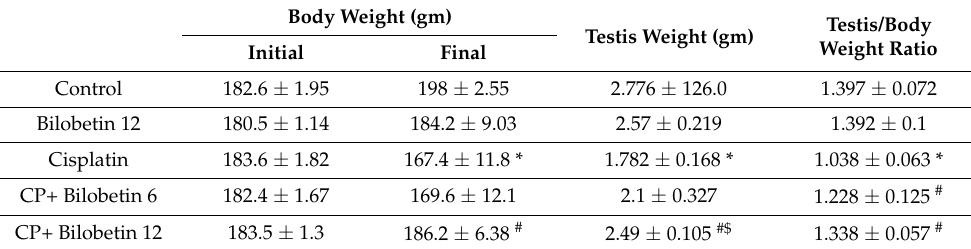
Table 2. Effects of Bilobetin treatment on testis/body weight ratio in Cisplatin-induced testicular toxicity in